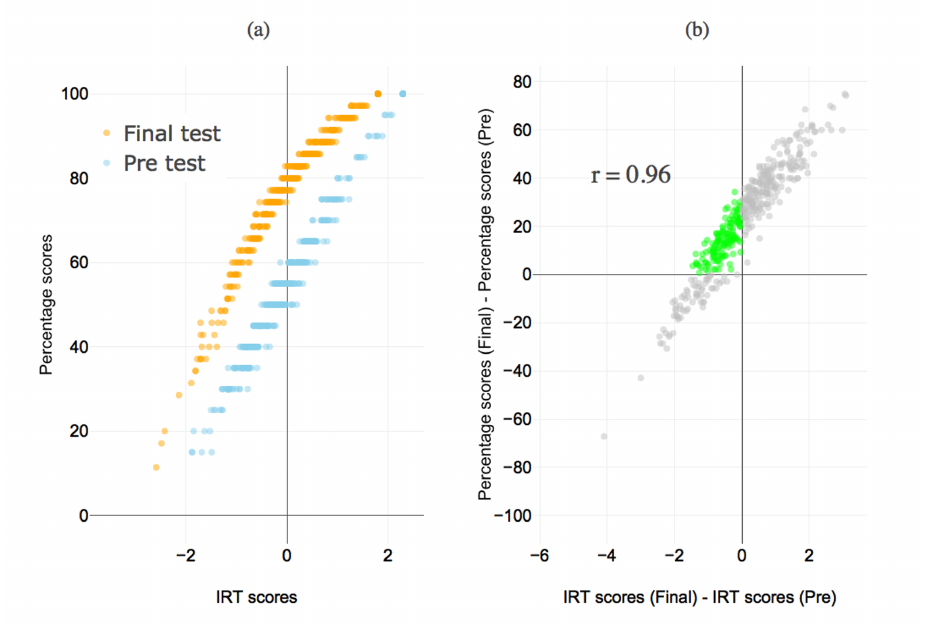
Figure 5. Comparison between the percentage and IRT scores ( a , b ). Table 1. Gain scores based on the percentage and IRT